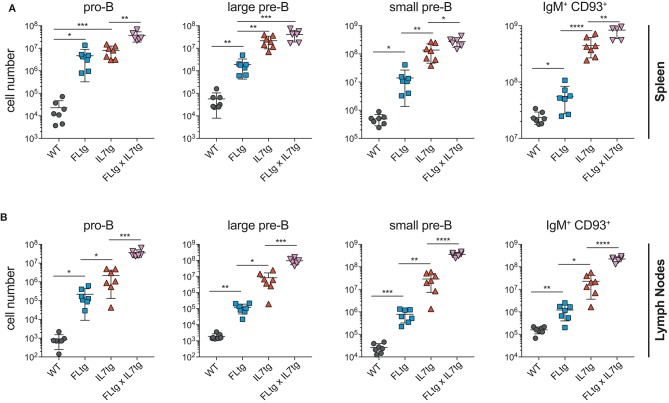
Accumulation of B cell progenitors in the spleen and lymph nodes of FLtgxIL7tg mice. Numbers of pro-B (CD19+IgM−CD117+), large pre-B (CD19+IgM−CD117−CD127+FSClarge), small pre-B (CD19+IgM−CD117−CD127−FSCsmall) and immature B (CD19+IgM+CD93+) in the spleen (A) and lymph nodes (axillary and inguinal) (B) of WT, FLtg, IL7tg and FLtgxIL7tg mice. B cell progenitors were identified by FACS as shown in Figure 2B. *p < 0.05, **p < 0.01, ***p < 0.001, and ****p < 0.0001. Error bars indicate standard deviation.